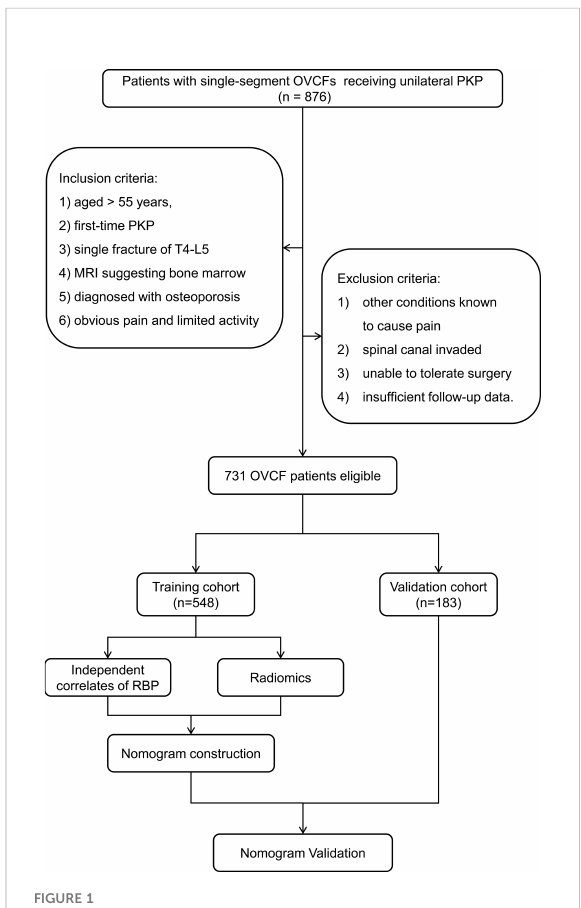
FIGURE 1 Flowchart of patient selection based on the inclusion and exclusion criteria and model design. OVCF, osteoporotic vertebral compression fracture; PKP, percutaneous kyphoplasty; RBP, residual back